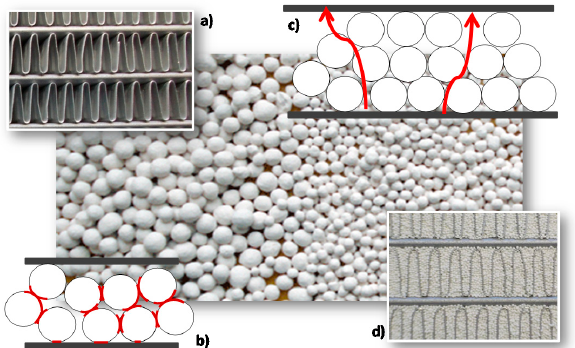
Figure 2. Comparison between characteristic properties of four Ad-HEX configurations.